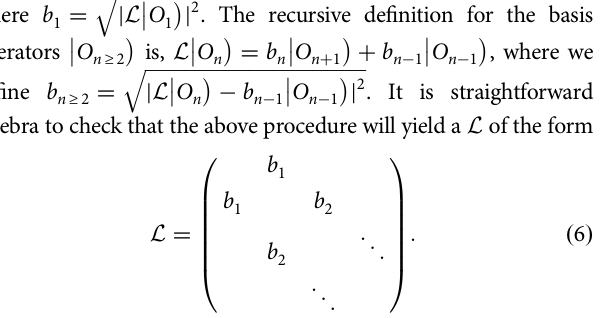
algorithm iteratively fi nds the operator basis that tri-diagonalizes L .